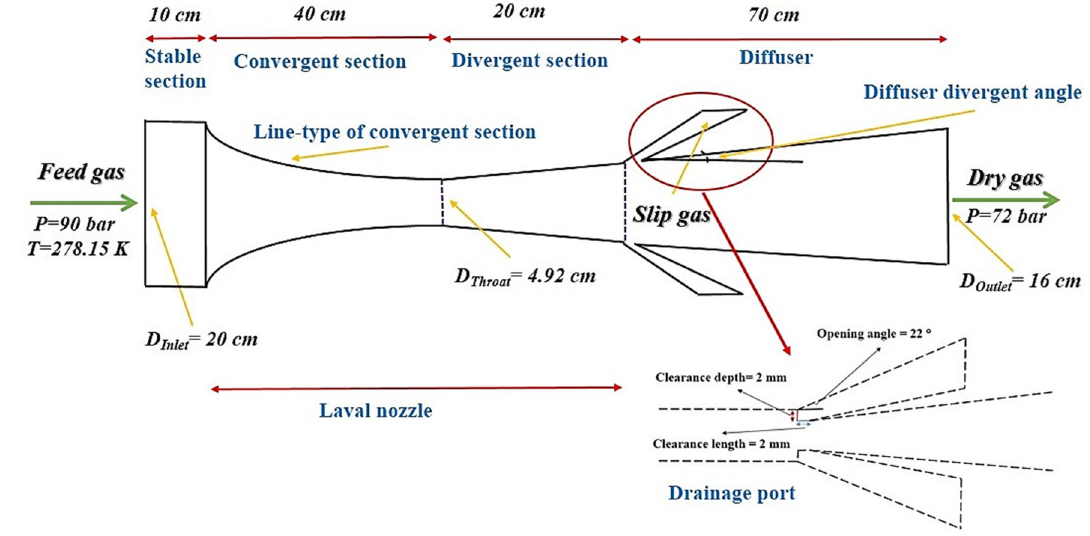
Figure 1. Schematic of the studied